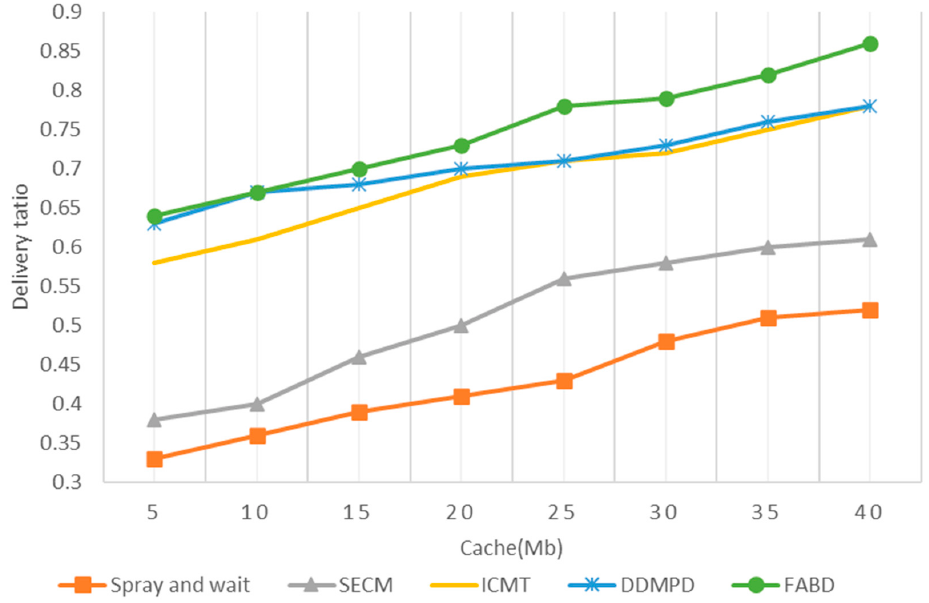
Figure 8. The relationship between delivery ratio and cache.